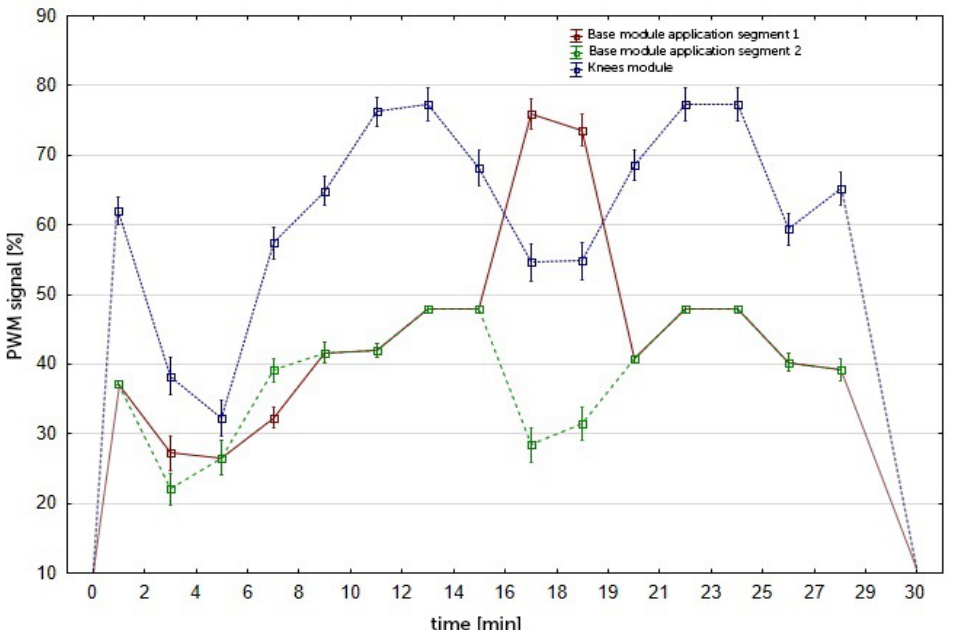
Figure 3. Voltage − current characteristics of the Knees program with the Knees S module (PWM: Pulse Width Modulation).